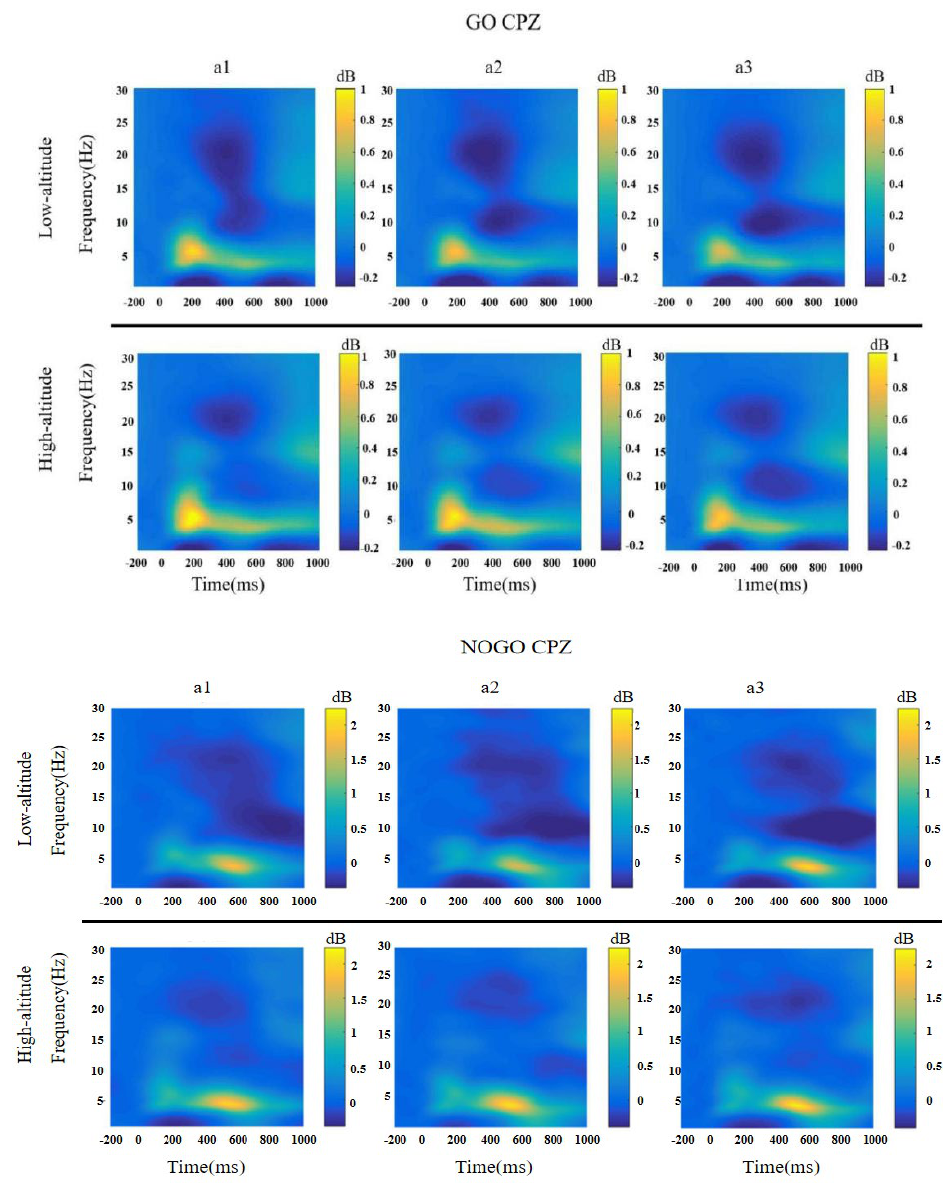
Figure 5. The average results of spectro-temporal analysis of EEG activity recorded from CPZ electrode sites during Go and No-Go trials. Table 6. Mean ERSP values for delta, slow alpha, fast alpha, and beta frequency bands (dB) (460– 700 ms) (M ± SEM).